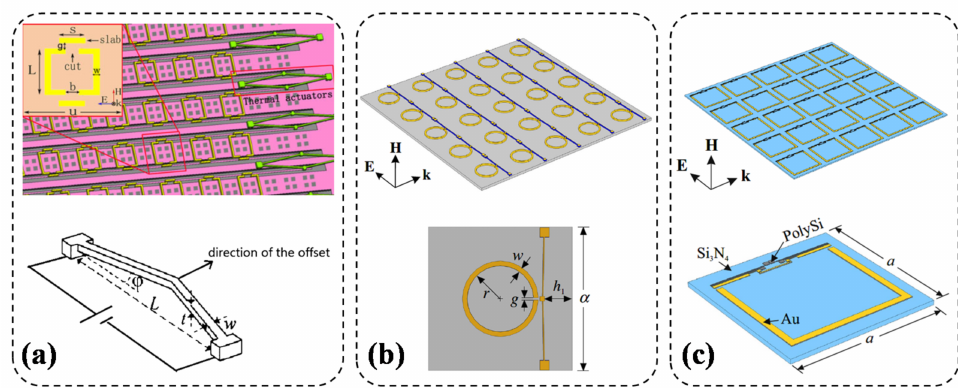
Figure 3. ETA-based horizontal tuning methods of metamaterial: ( a ) schematic of the tunable metamaterials and the two-cut SRR unit cell [63]; ( b ) schematic of tunable metamaterial and the unit cell using the chevron beam ETA [64]; ( c ) schematic of two independent ETA, SRR, and unit cell